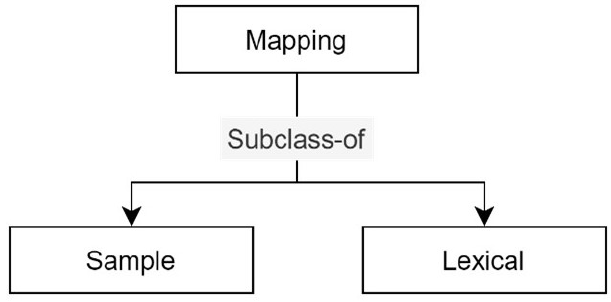
Figure 2. Taxonomy for the Mapping class